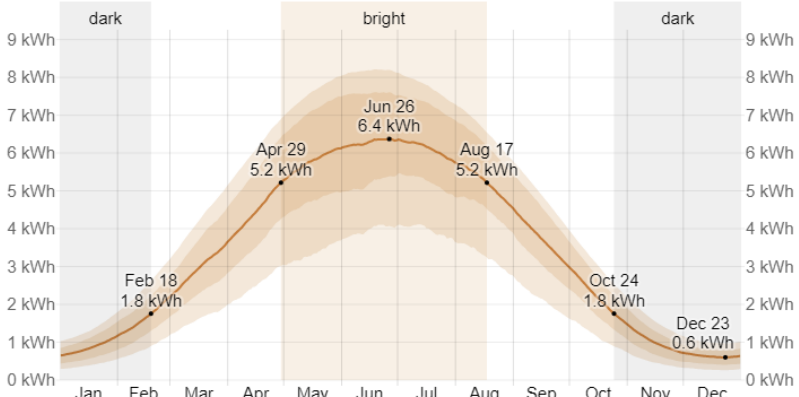
Figure 18. Average daily incident shortwave solar energy in Warsaw, Poland [76].